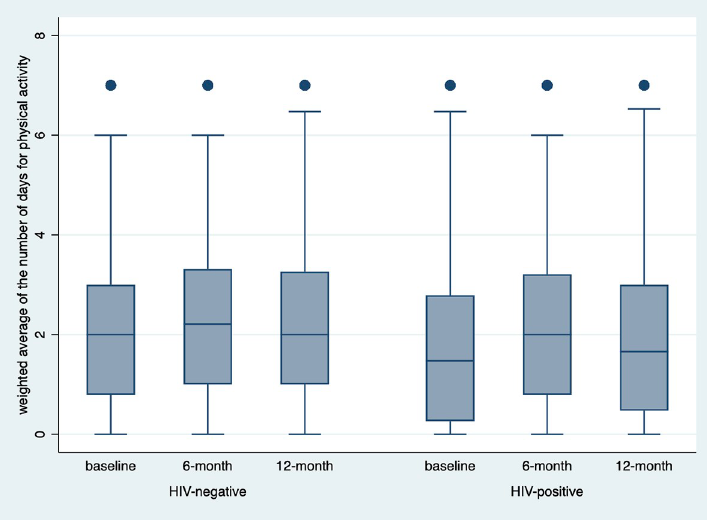
Fig 1. Distributions of the weighted average days for physical activity by HIV status across